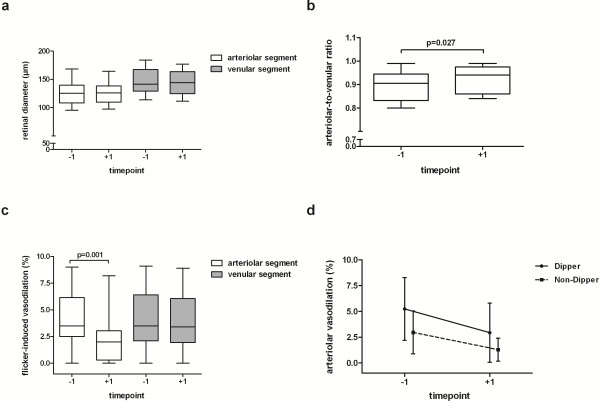
a-d Functional and structural changes of retinal vessels in colorectal cancer patients in response to bevacizumab infusion. While the diameter of retinal vessels were unaffected by bevacizumab treatment (Figure 1a) it evoked an increase in arteriolar-to-venular ratio (Figure 1b) and a decrease in flicker-induced arterial vasodilation (Figure 1c). The reactivity of retinal arteries to flickering light tended to be lower in patients with a pathological nocturnal blood pressure profile (non-dippers) than in those with physiological nocturnal blood pressure profile (dippers) (Figure 1d). Legend: before (day-1) and after (day + 1) bevacizumab infusion.